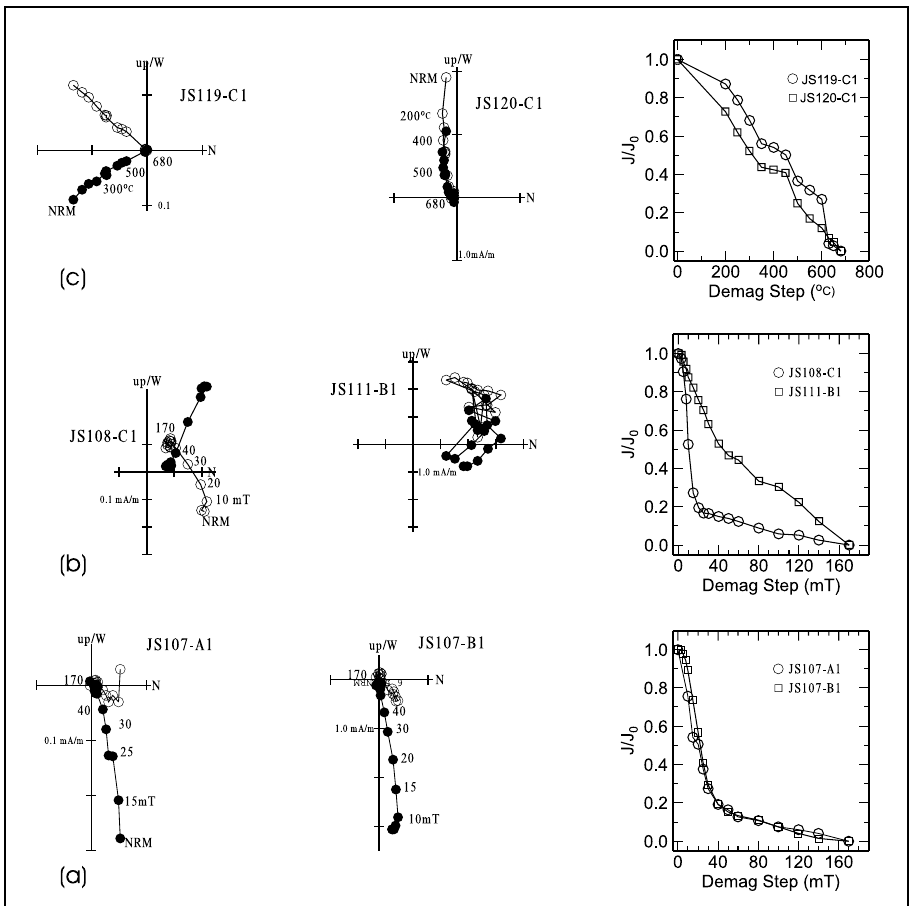
Fig. 4 – Examples of progressive AF and thermal demagnetization results of samples with transitional (a and c) and normal (b) magnetic polarities. Legends are same as in Fig. 3.